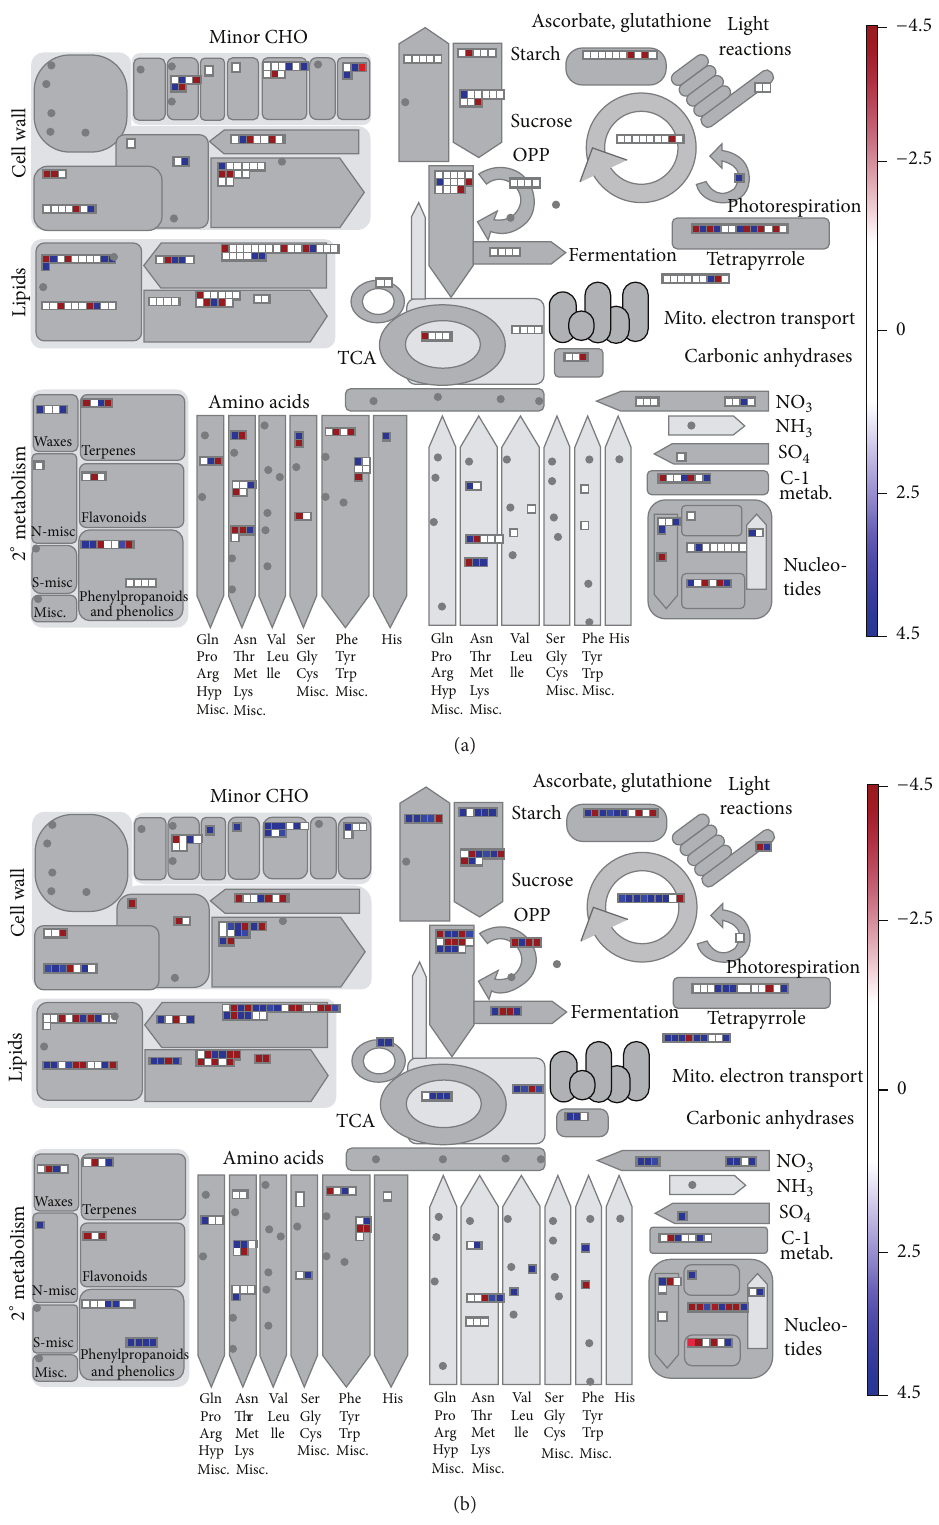
Figure 6: Overview of metabolic responses to water deficit stress. (a) Distribution of water deficit-responsive transcripts in shoots and (b) distribution of water deficit-responsive transcripts in